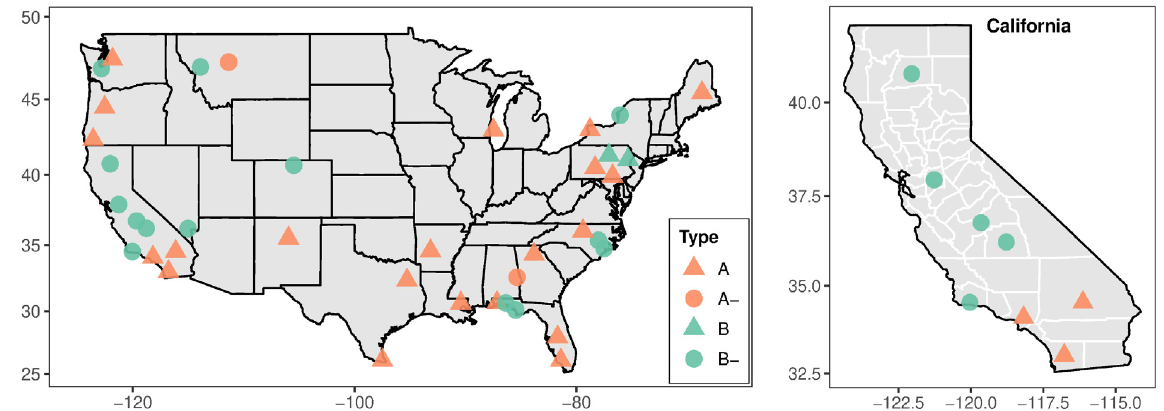
Fig 3. Locations of the MSA and their types at 95% confidence as summarized in Table 2. Top panel: contiguous USA (the black lines delineate states). Bottom panel: the state of California (the white lines delineate counties). The colors distinguish the types A/A − and B/B − . The shape of the symbols indicates the direction of development, i.e. triangles for g − g 0 > 0 and circles for g − g 0 < 0 (“time reversal”).